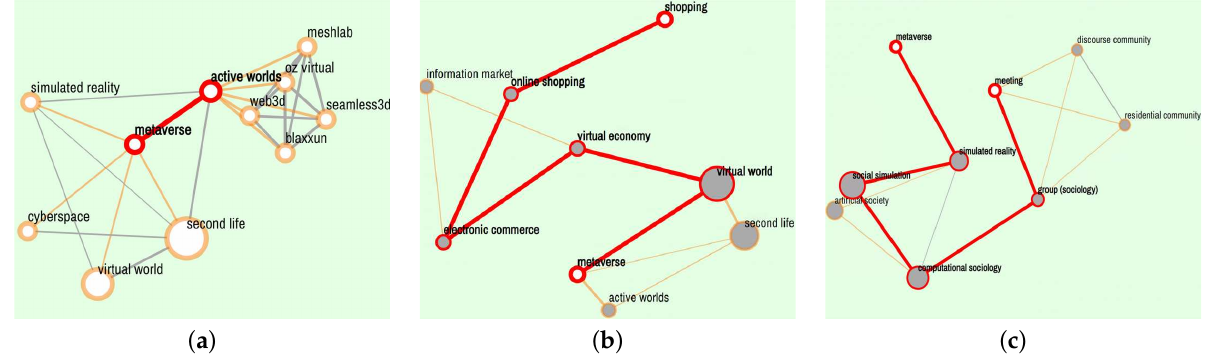
Figure 6. Comparisons of the results from “Explore” and “Search Path”: ( a ) the “Explore Spe- cific” results for “metaverse”; ( b ) the “Search Path-Professional” results between “metaverse” and “shopping”; ( c ) The “Search Path-Professional” results between “metaverse” and